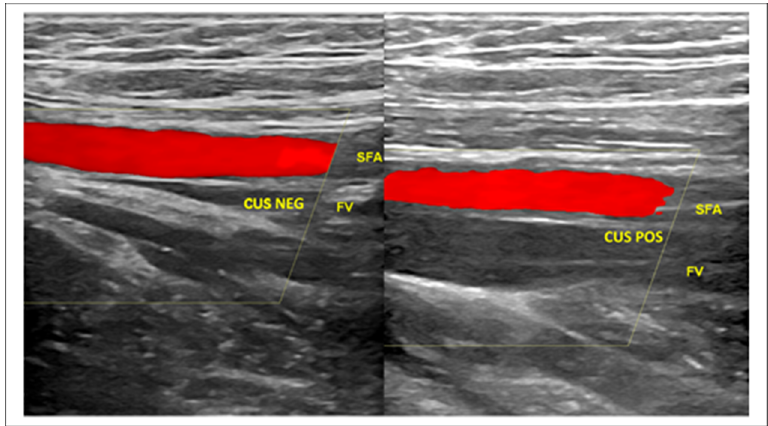
Figure 4. CUS maneuver for rapid identification of DVT. ( Left ) The real time compression by the ultrasound probe of the femoral vessels at the thigh determines the collapse of the femoral vein. CUS maneuver negative for DVT. ( Right ) The same maneuver in the case of femoral vein thrombosis does not demonstrate venous collapse. CUS maneuver positive for DVT. Legend: SFA—Superficial Femoral Artery; CUS NEG—Negative for thrombosis Compression Ultrasonography; FV—Femoral Vein; CUS POS—Positive for thrombosis Compression Ultrasonography.